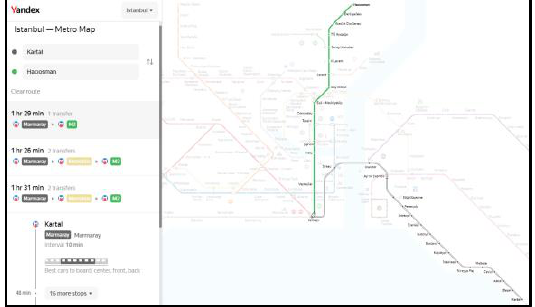
Figure 15. Yandex Maps Istanbul - Metro map